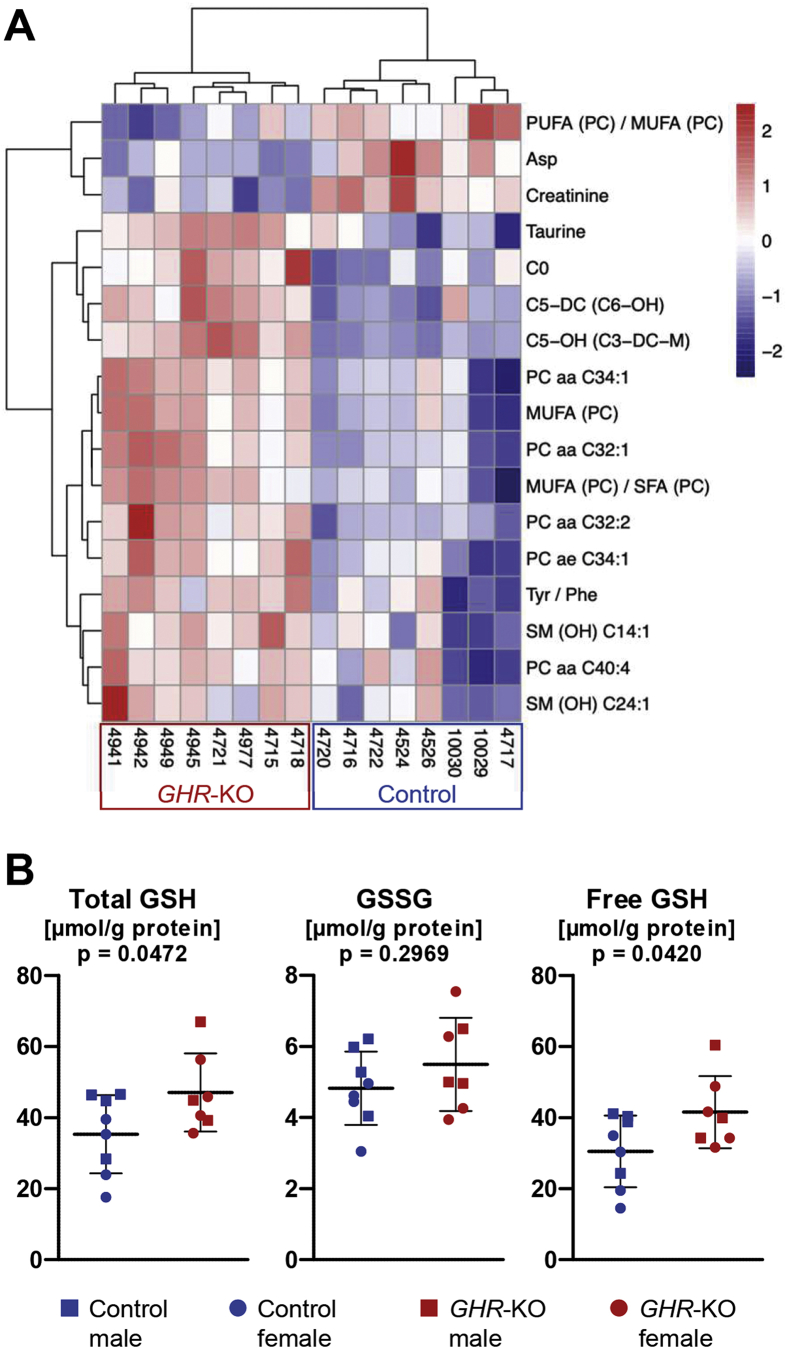
Metabolome differences between liver samples from GHR-KO and control pigs. A: Heatmap of metabolites significantly affected by group. B: Concentrations of total glutathione (GSH), oxidized glutathione (GSSG) and free GSH.